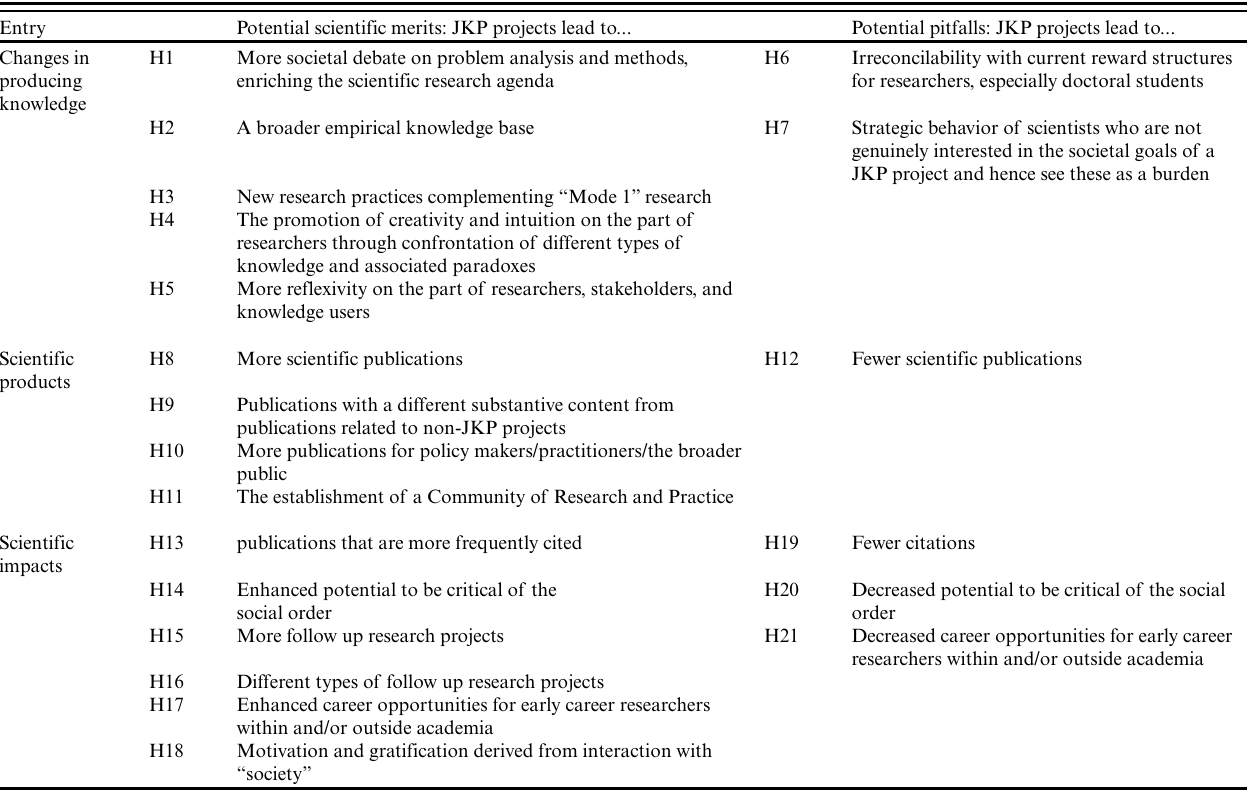
Table 2 . Conceptualizing the scientific merit of joint knowledge production (JKP) projects: process, product, and impact-related